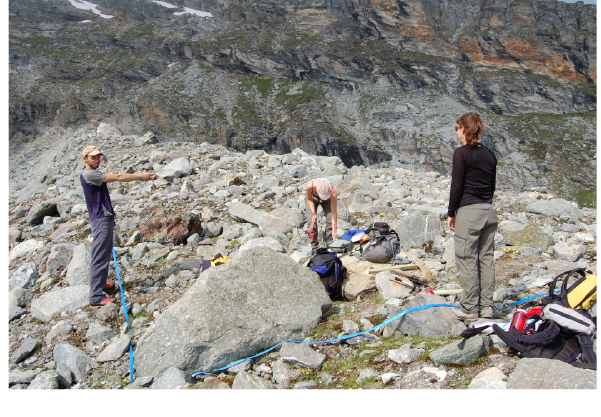
r Fig. 2. The iButton DS1922L that was used for temperature measurements.